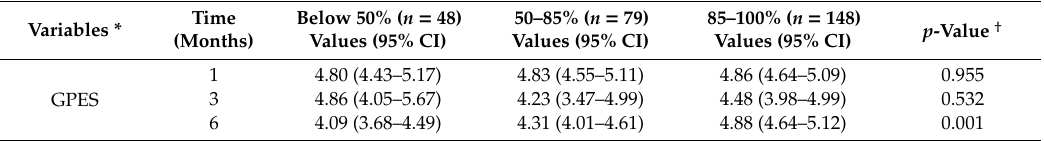
Table 4. Changes in the estimated global perceived e ff ect of satisfaction in patients who were treated using decompression and adhesiolysis using an inflatable balloon catheter.